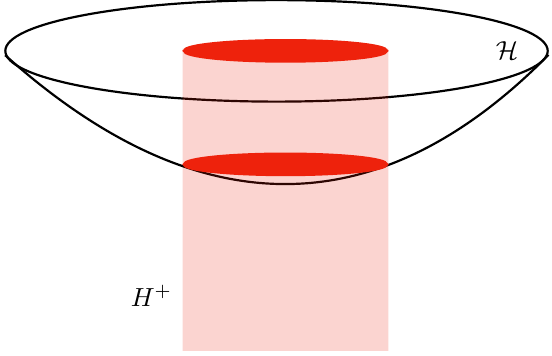
Figure 2 . Horizon H + intersecting the timelike infinity hyperboloid H . In the limit τ → ∞ the intersection shrinks to a